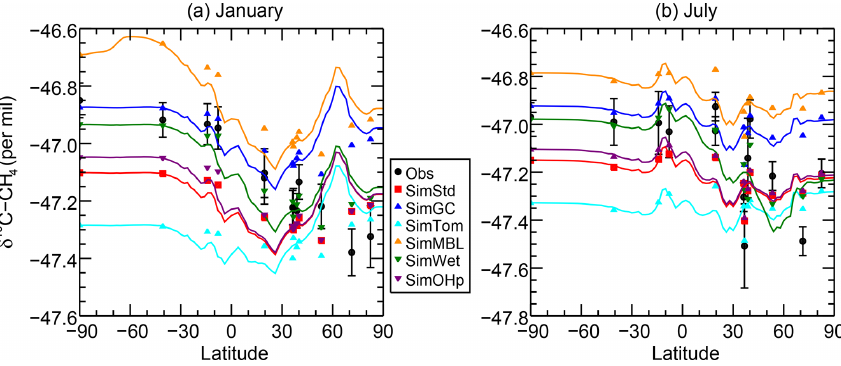
Figure 7. δ 13 C of CH 4 as a function of latitude in (a) January and (b) July 2004 for the GMD observations (black circles), SimStd (red), SimGC (dark blue), SimTom (cyan), SimMBL (orange), SimWet (green), and SimOHp (purple). Error bars represent the maximum of the analytical uncertainty (0.06‰) and the standard deviation of individual measurements in the month for each site. The colored lines represent the simulated zonal mean, while the colored symbols represent the simulation sampled at the location of the GMD